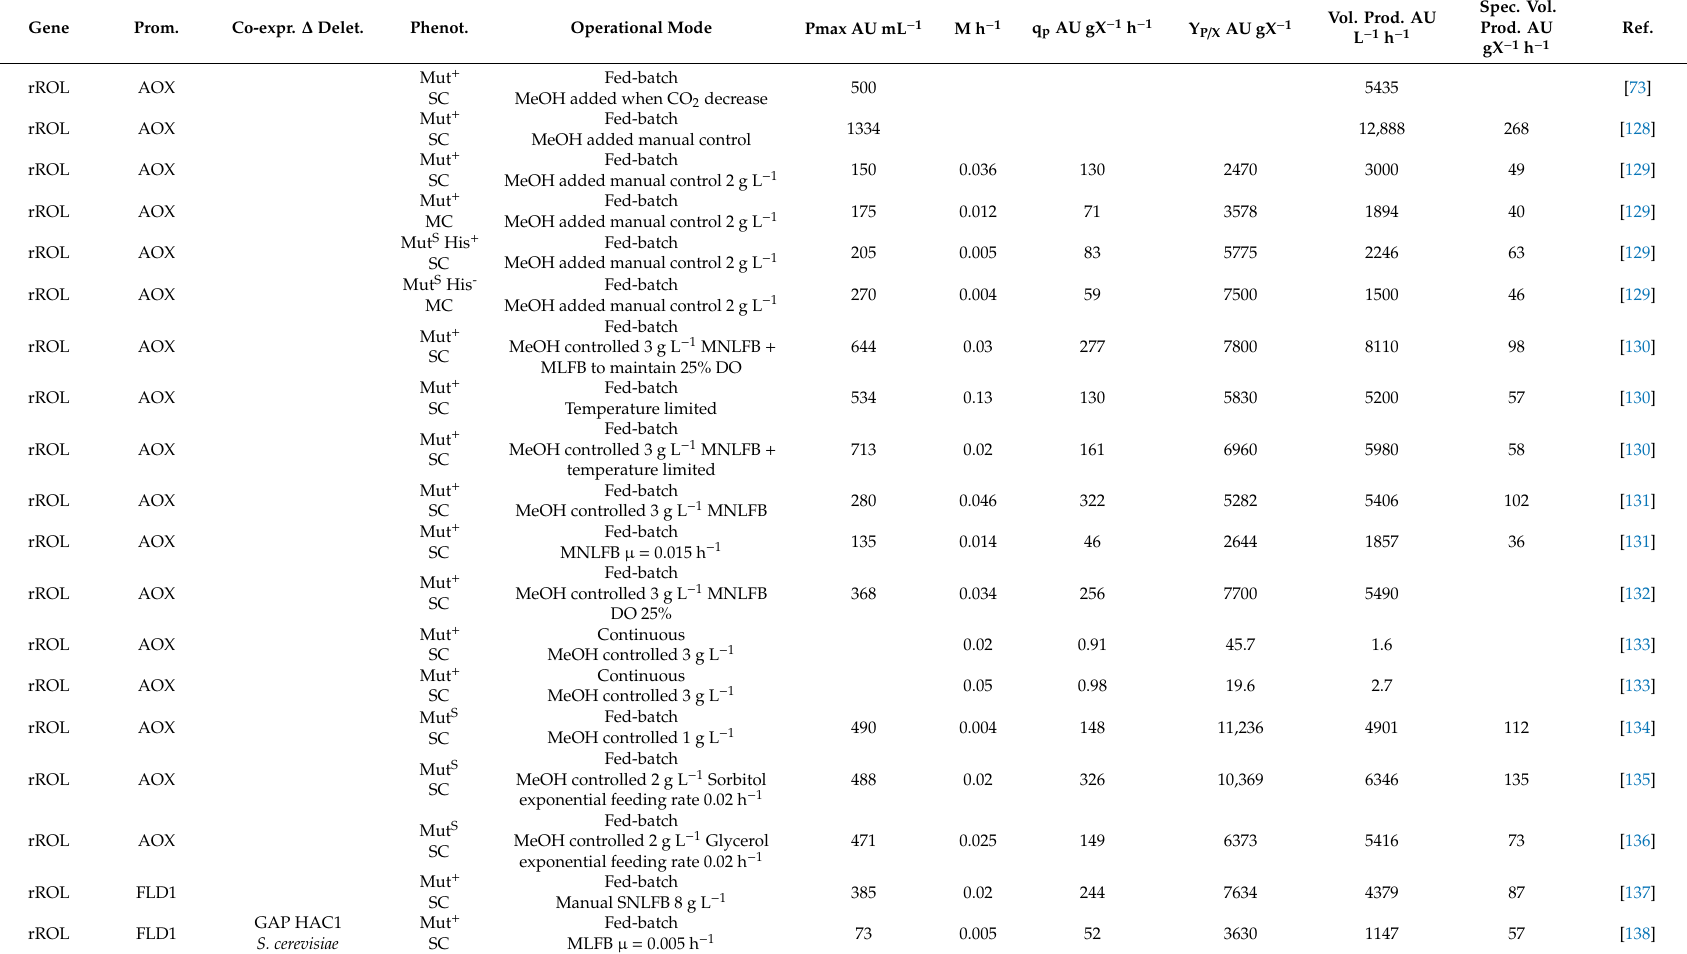
Table 4. Summary of K. pha ffi i cell factory expressing Rhizopus oryzae